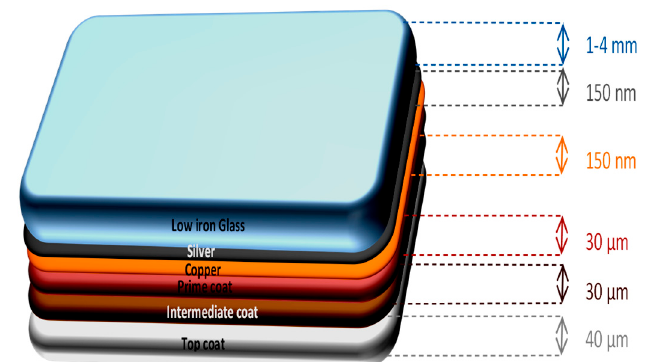
Figure 1. Schematic composition of silvered-glass.